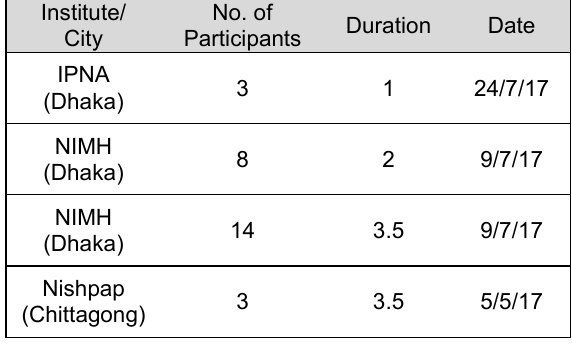
Table 2: FGD Location and Participation